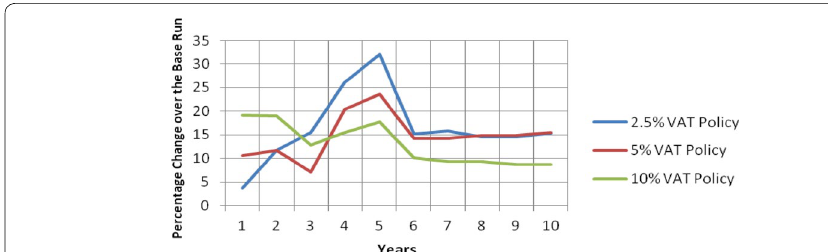
Fig. 11 Percentage changes in government real expenditure